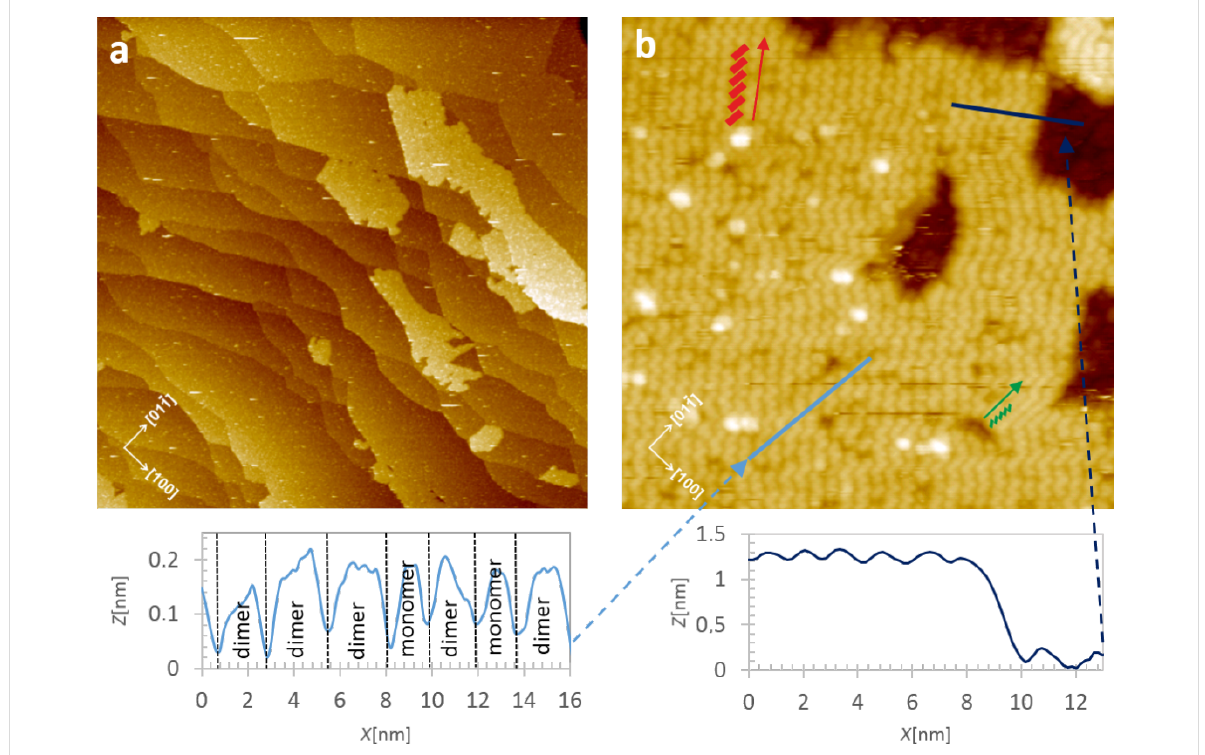
Figure 3: Geometrical characterization of 1.3 ML of ZnPc molecules on a TiO 2 (011)-(2×1) surface after deposition at 150 °C. (a) The overview 250 × 250 nm 2 empty state STM image measured at RT. (b) The high resolution empty state STM images (50 × 50 nm 2 ) taken at room temperature. Red and green arrows and rectangles indicate the ordering directions and the basic molecular building blocks, i.e., upright standing molecules. The linear profiles taken along the direction of the paired molecular building blocks (“bricks”) and across the island edge are shown below the STM image. In two cases the building blocks are smaller and most likely consist of monomers only. The STM scanning parameters are: I = 3 pA, U = 2